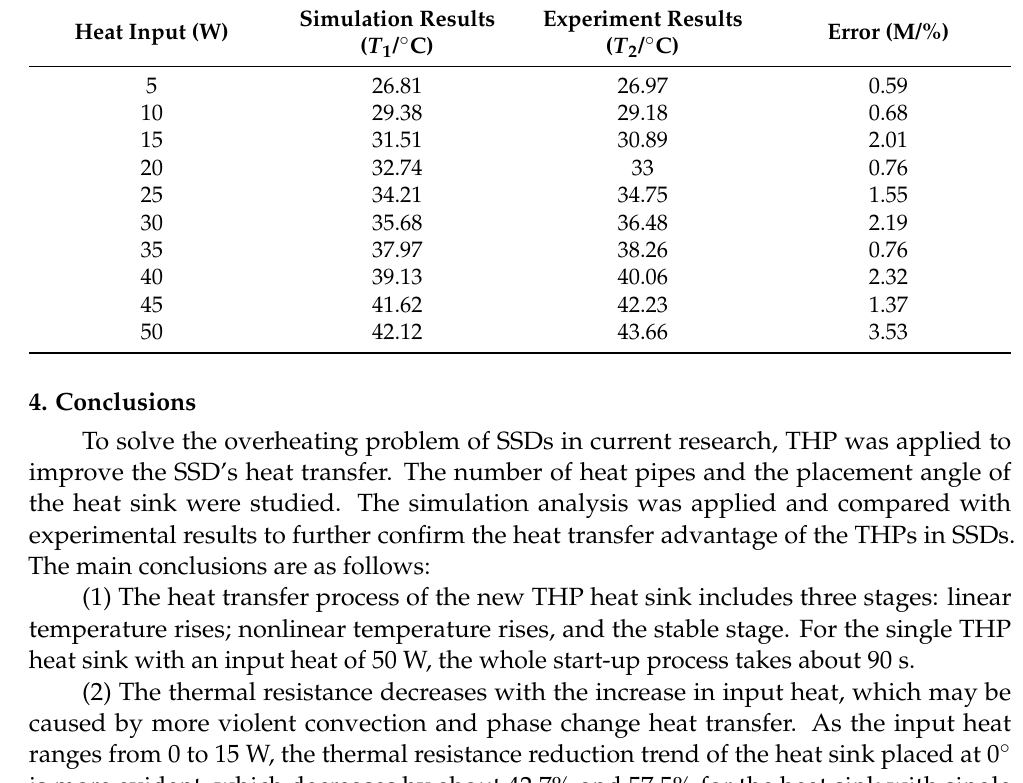
Table 5. Comparison between the experiment and simulation